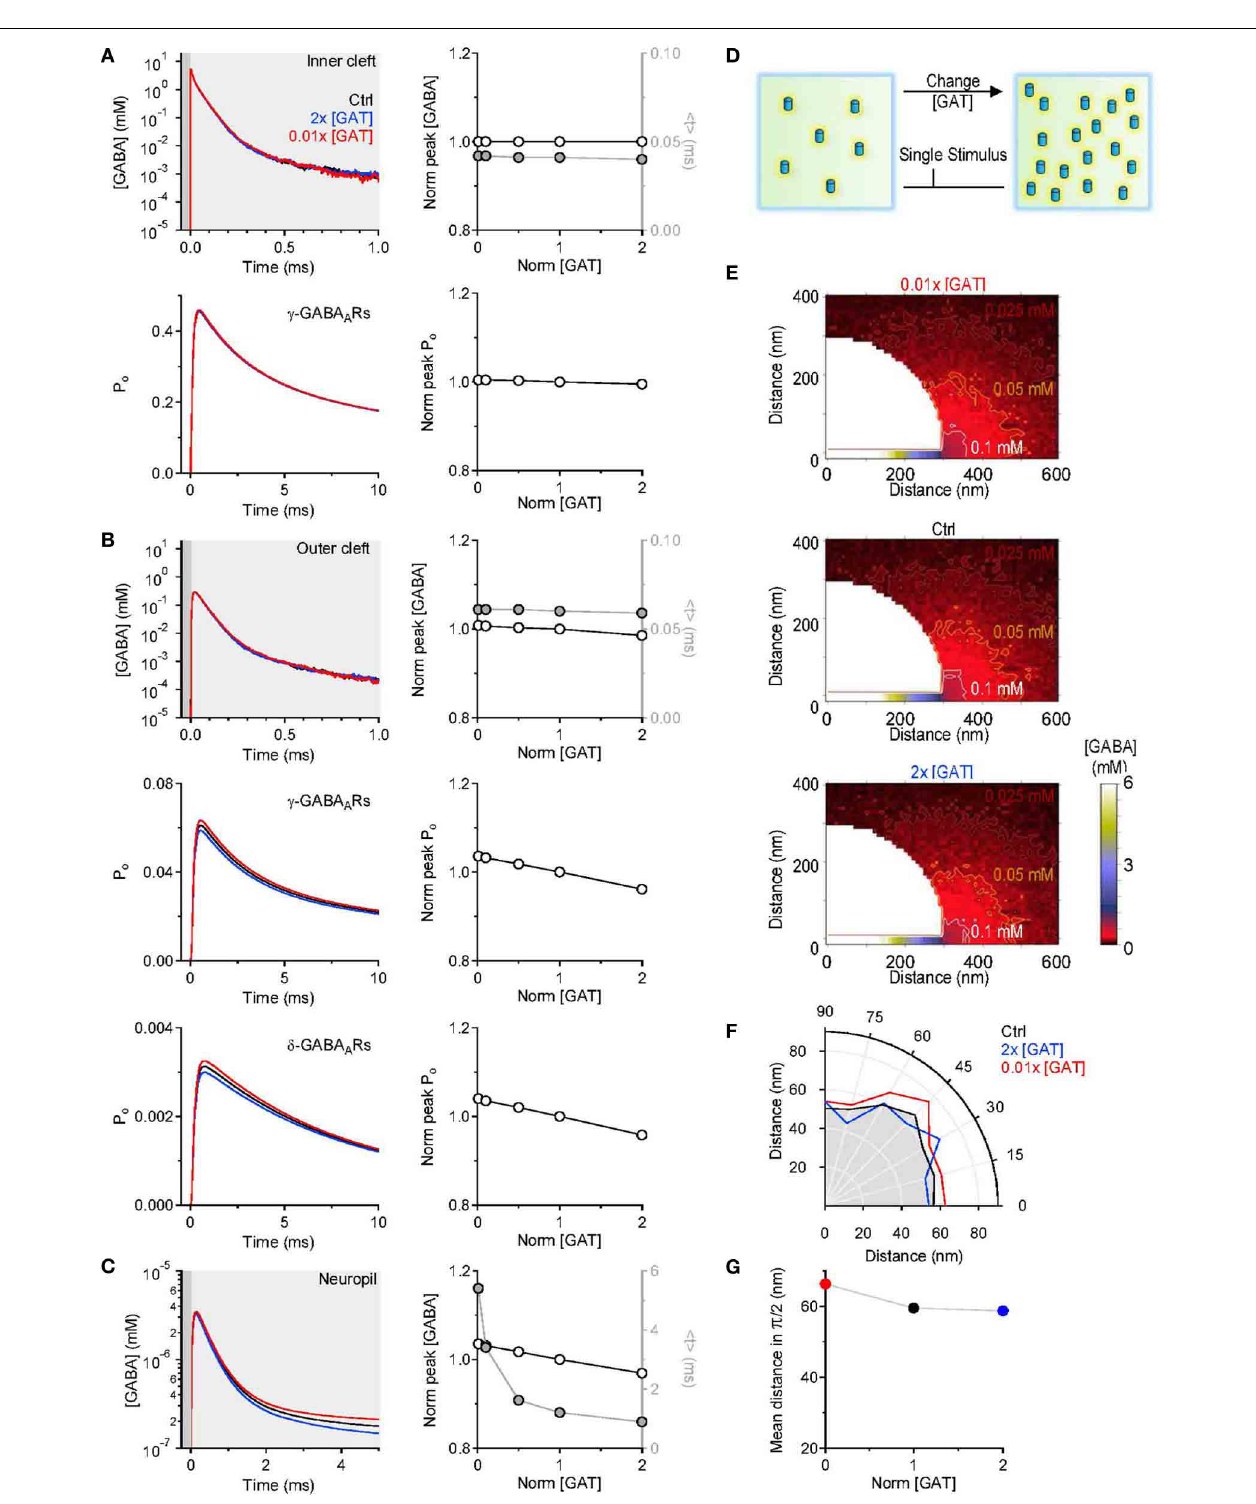
FIGURE 3 | Changing the concentration of GABA transporters alters the lifetime of GABA outside the synaptic cleft. (A) GABA concentration profile in the inner cleft volume measured when varying the concentration of GABA transporters in the entire simulation environment (top left). The peak of the GABA concentration was normalized by its value in control conditions ( left axis and white symbols ). The normalized peak and the centroid ( < t > , right axis